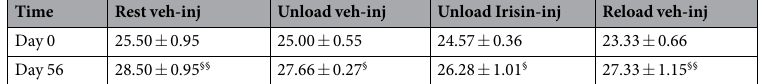
Table 2. Mouse body weight (grams). Curative Protocol: comparisons of Body Weights (grams) of male C57BL/6 mice in the four Experimental Groups before (day 0) and after hind-limb suspension or reload activity (Day 56). Data are presented as mean ± SEM. § p < 0.05, §§ p < 0.01 (p value Day 56 Vs Day 0). No significant differences were detected between groups of mice at the end of treatment.